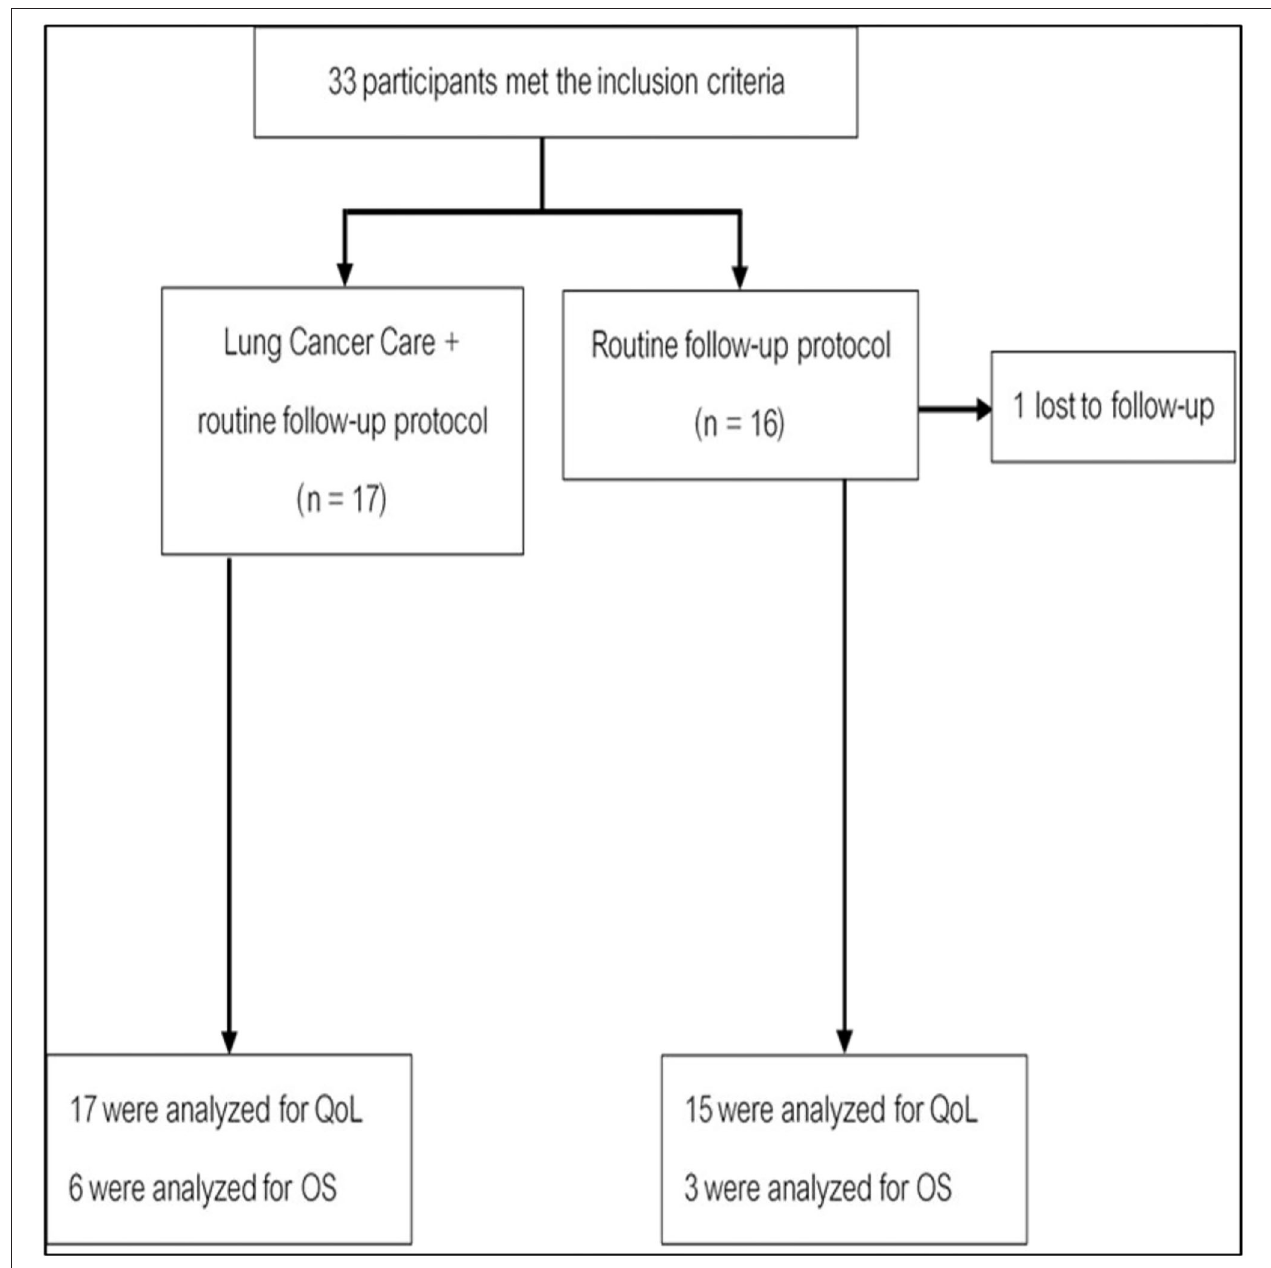
FIGURE 4 | A consort diagram for enrolled patients in cohort 2.